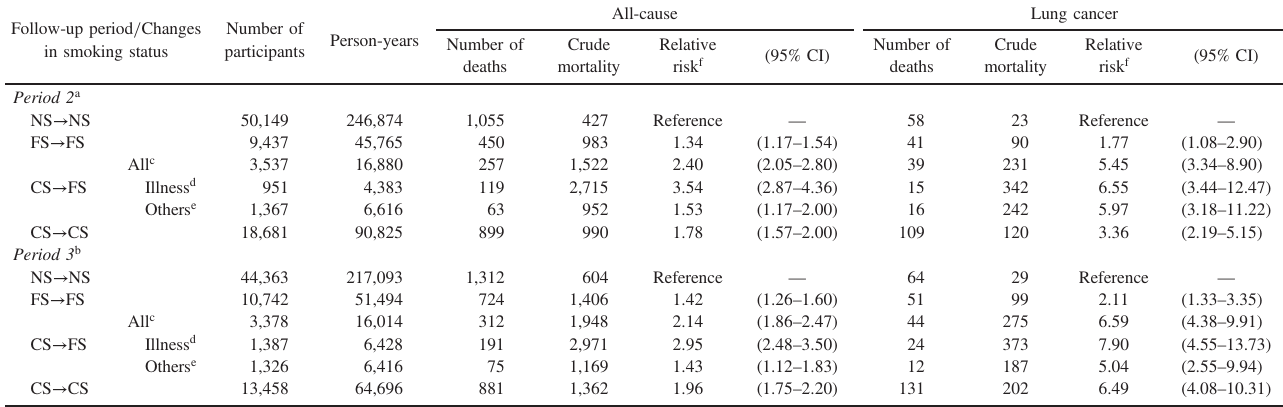
Table 4. Number of deaths from all-cause and lung cancer and relative risk by changes in smoking status and reasons for quitting